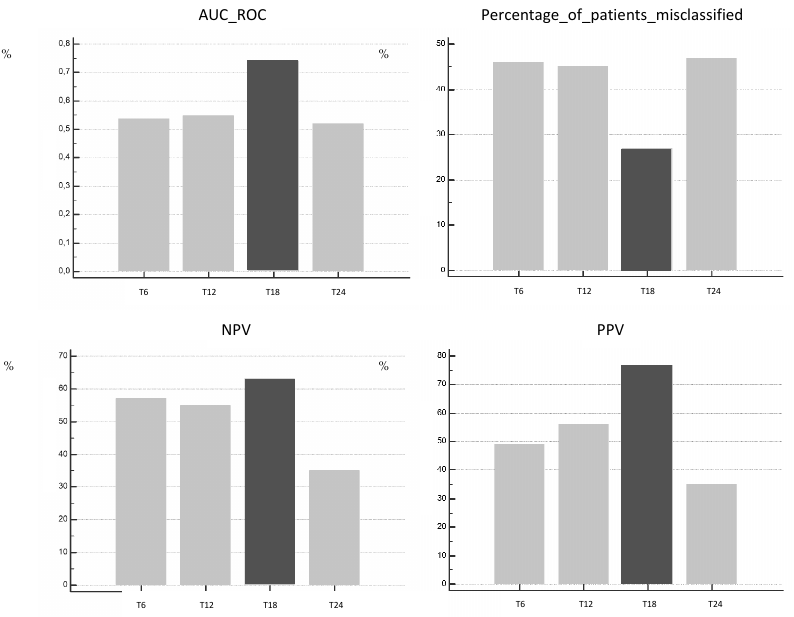
Figure 3. Performance after cross-validation of predictive models of loss of functional autonomy at 6 months (T6), at 12 months (T12), at 18 months (T18) and at 24 months (T24). AUC-ROC = area under the curve of the receiving operator characteristic curve. NPV = Negative predictive value (percentage). PPV = Positive predictive value (percentage).